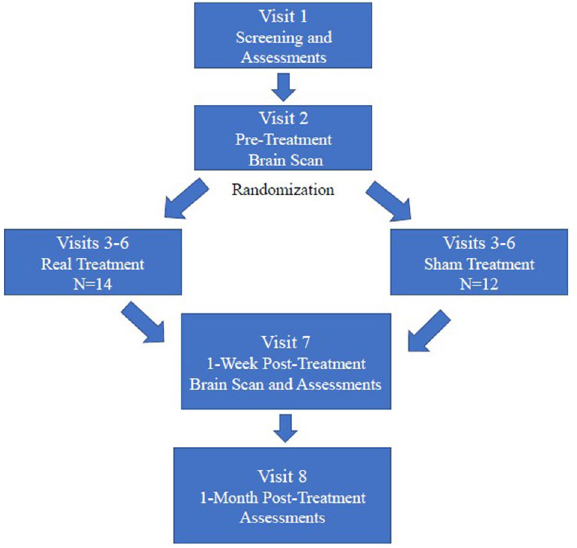
Figure 1. Study protocol flow